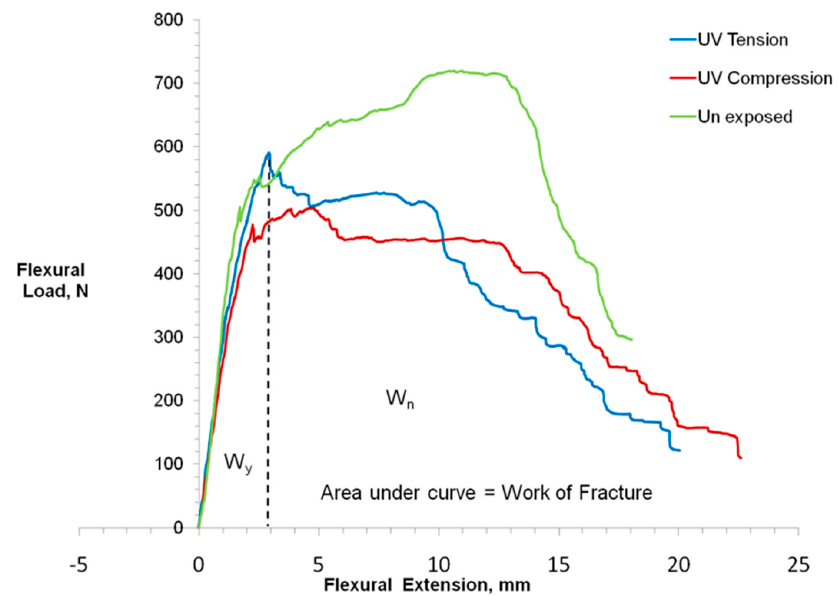
Figure 6. Preliminary results of the three-point bend tests conducted on the UV exposed samples indicating brittleness induced in the samples.